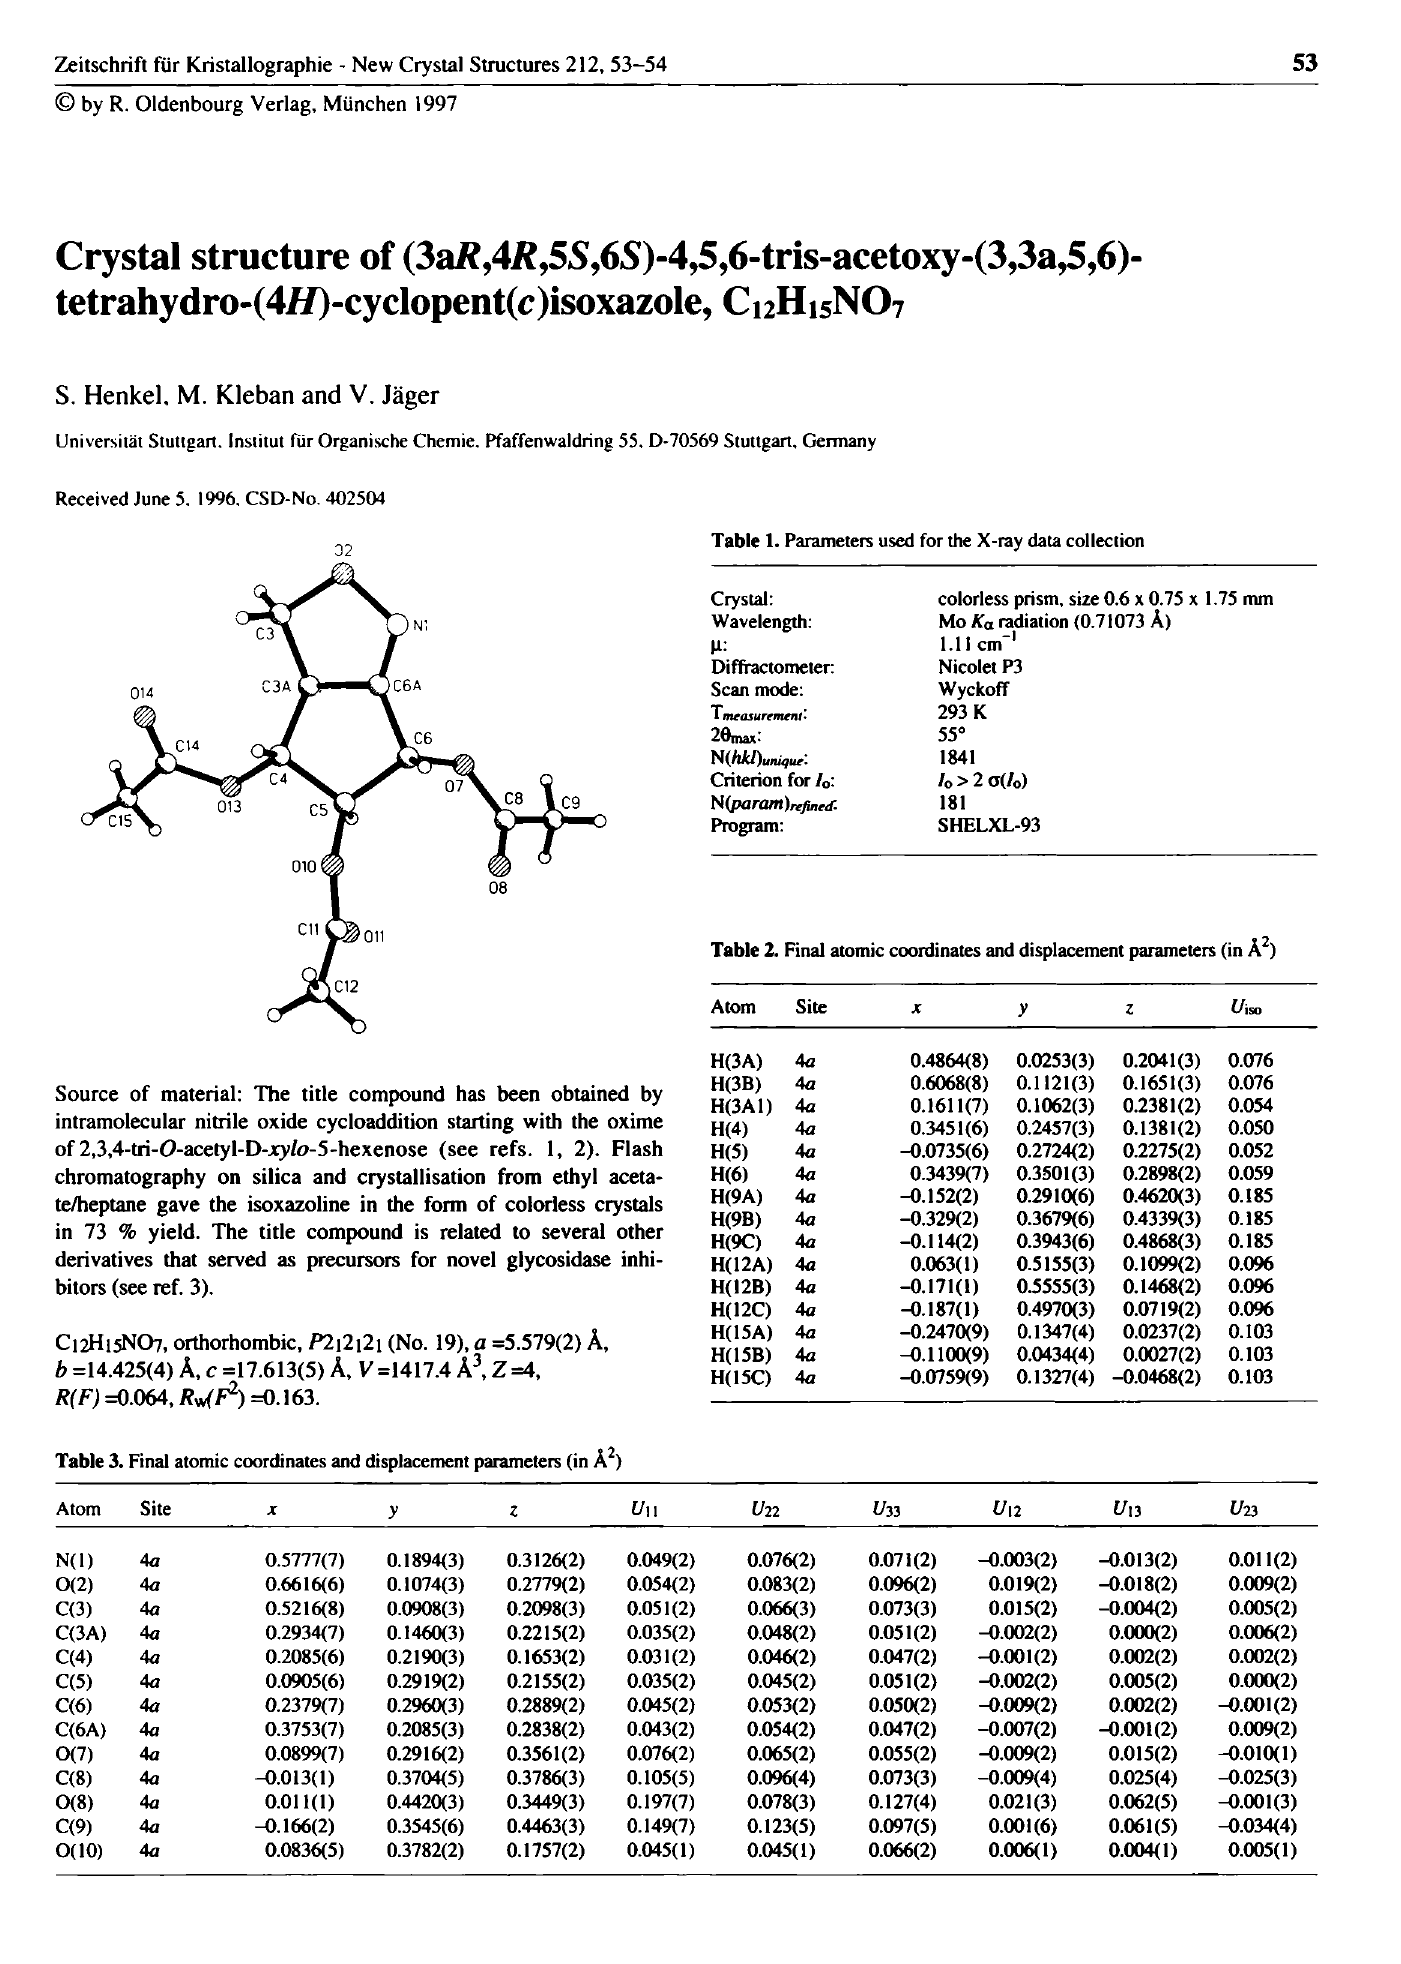
Table 3. Final atomic coordinates and displacement parameters (in À 2 )